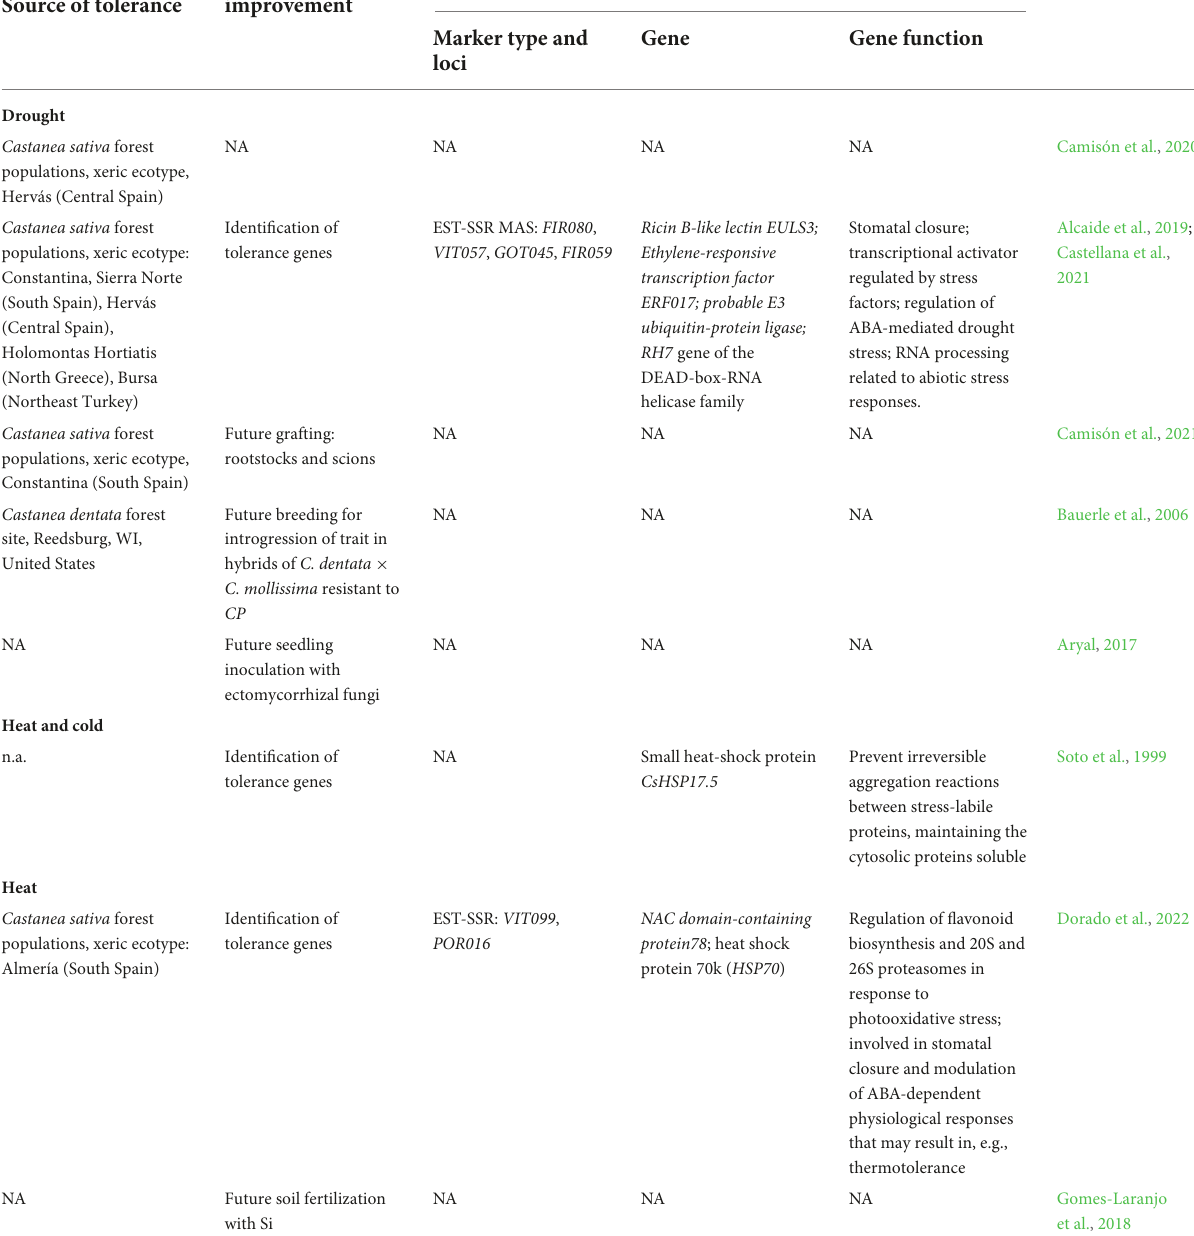
TABLE 4 Summary of the tolerance to abiotic stresses in Castanea sativa and C. dentata